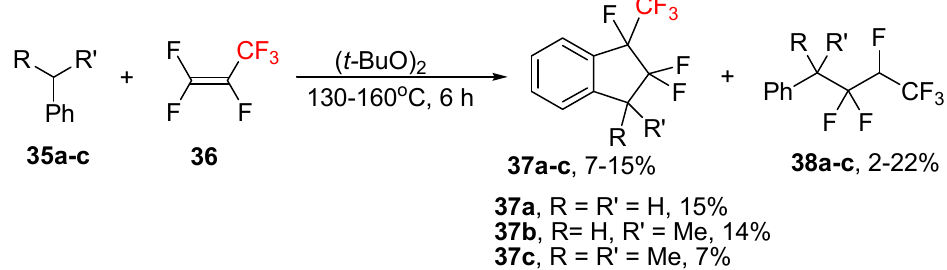
Scheme 23. Synthesis of 1-CF 3 -indanes 37a-c by free radical reaction of alkylbenzenes 35a-c with hexafluoropropene 36 .